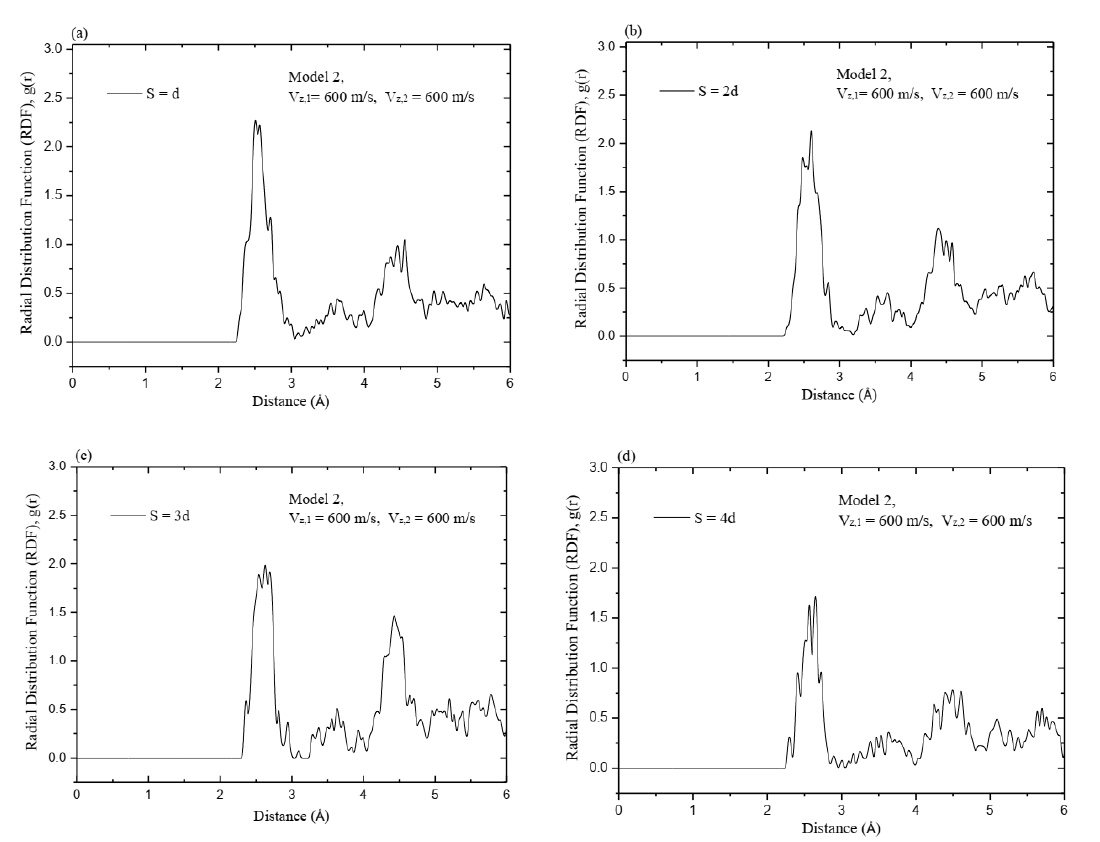
Figure 14. RDFs at V z ,1 = 600 m/s and V z ,2 = 600 m/s in Model 2: ( a ) S = d, ( b ) S = 2d, ( c ) S = 3d and ( d ) S =